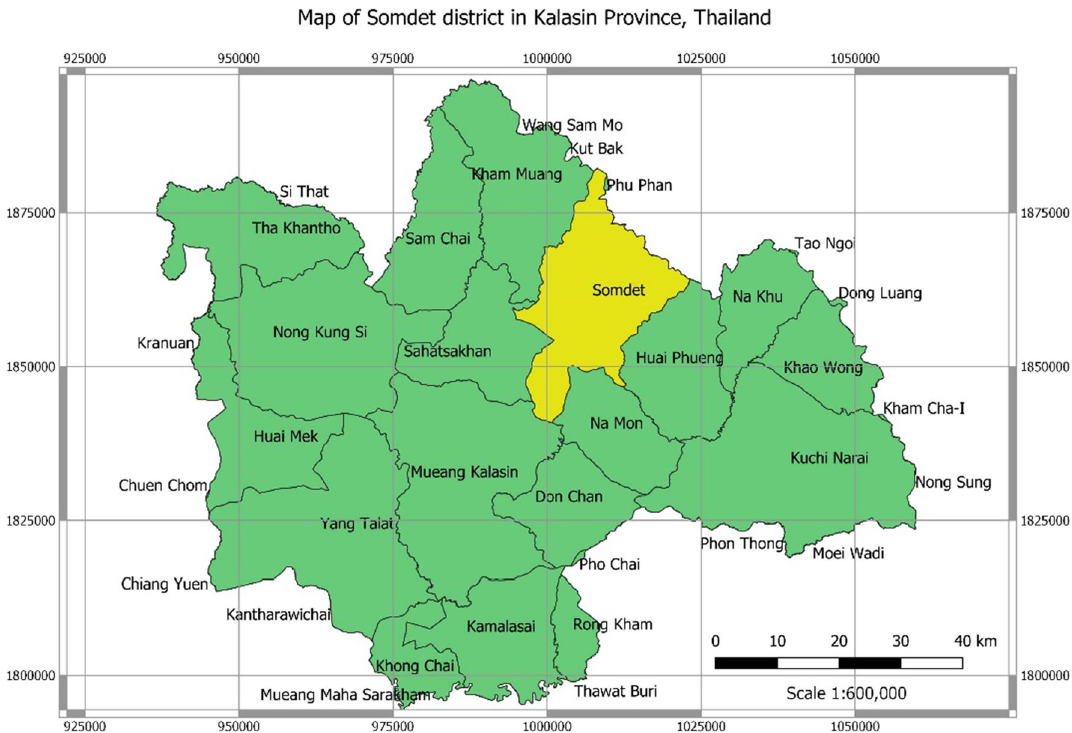
Fig. 1 Map of Kalasin